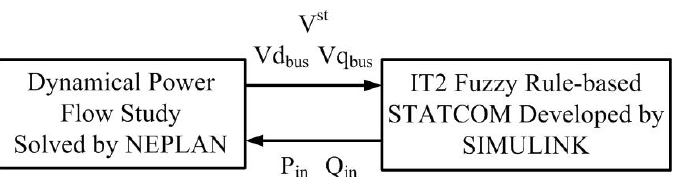
Figure 5. Co-simulation conducted by integrating NEPLAN with